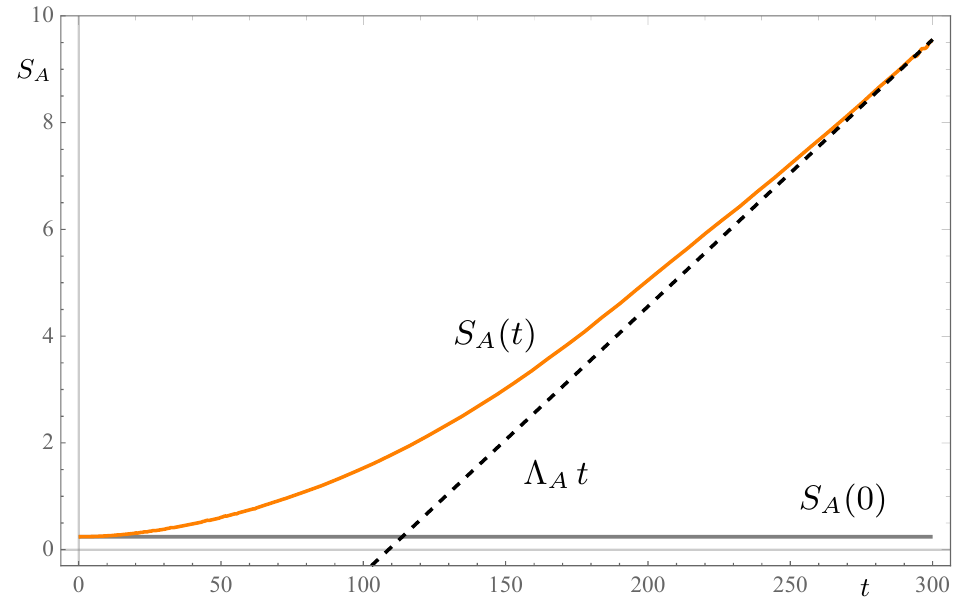
Figure 7 . Preheating and parametric resonance . We compute the entanglement entropy S A ( t ) numerically. The subsystem is de(cid:12)ned in (4.17), the time evolution is governed by the Hamiltonian presented in (4.25) and we start in the Minkowski vacuum state. We set R = 1, M 0 = 1 and v 2 = 0 : 1 leading to the entanglement production rate (cid:3) A = 0 : 05. The quantity S A (0) is the 0 entanglement entropy of the Minkowski vacuum and the linear production phase is reached after an initial